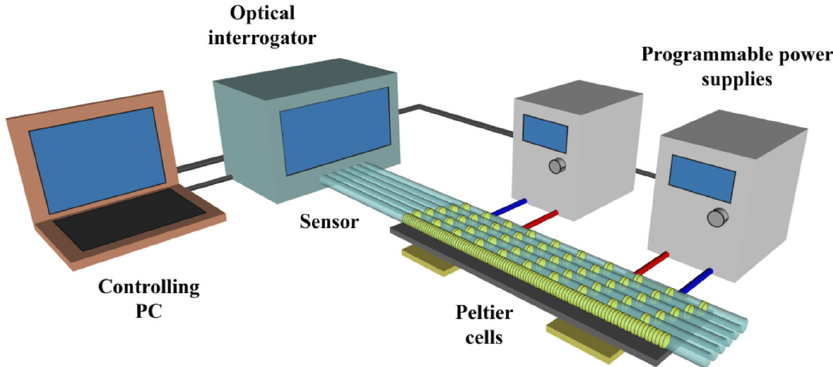
Figure 3. Principle scheme of the experimental setup.